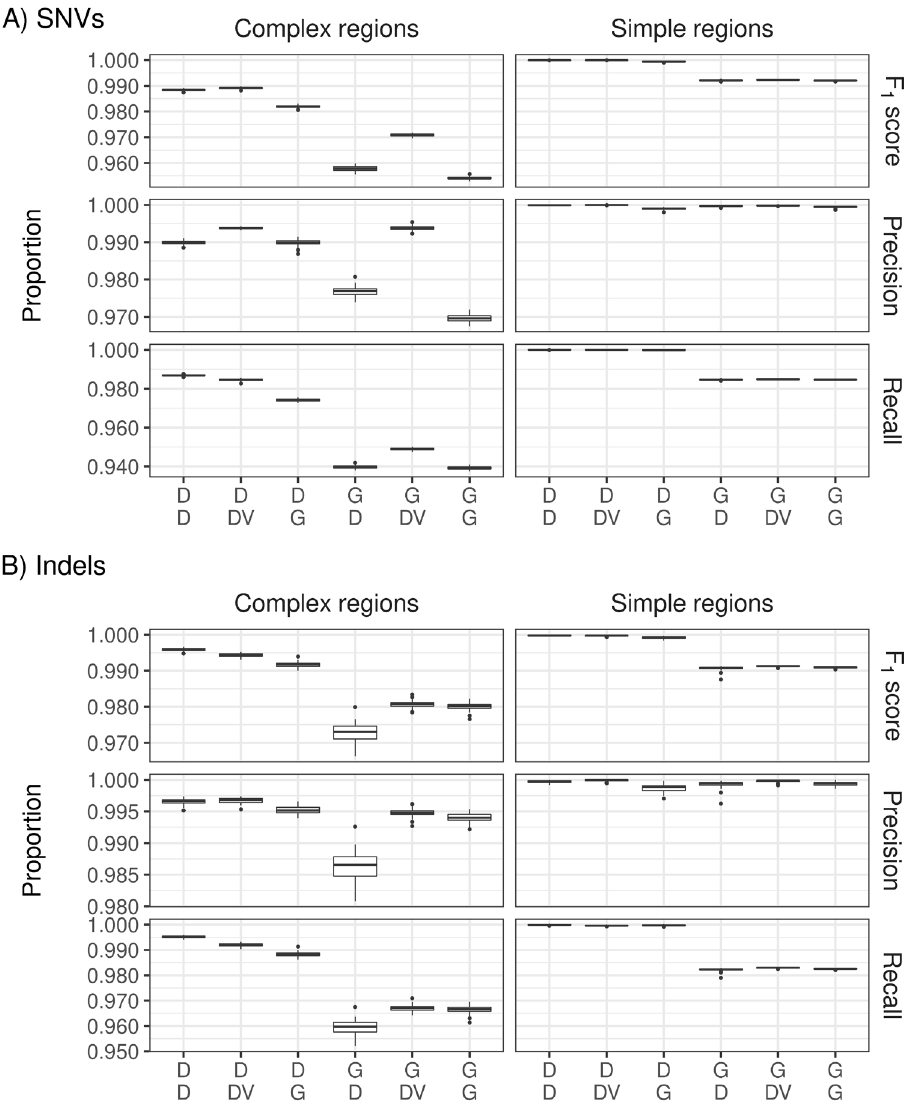
Figure 4. Percentages of F 1 score, precision, and recall for complex-to-map (complex) and simple-to-map (simple) regions for single nucleotide variations (SNVs) (upper 6 panels) and Indels (lower 6 panels) for the 6 pipeline combinations, based on chromosomes 20–22 of the genome in a bottle sample HG003. Labels on the x-axis are defined in detail in Fig. 2. D DRAGEN, DV DeepVariant, G